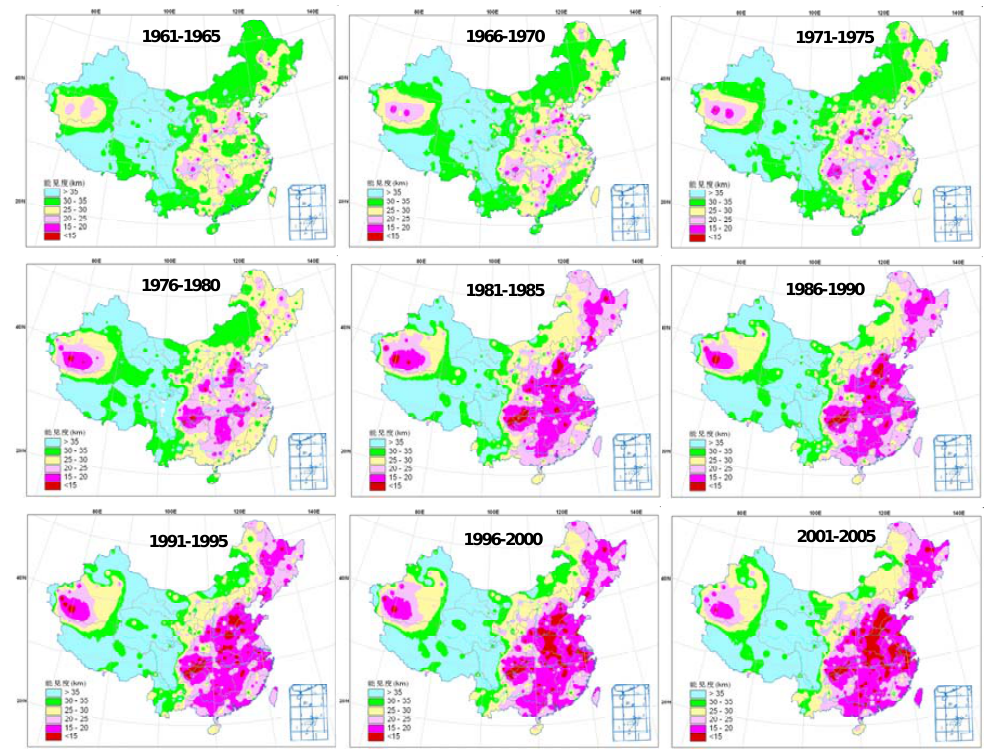
Fig. 9. Every five year mean visibility changes since 1960.